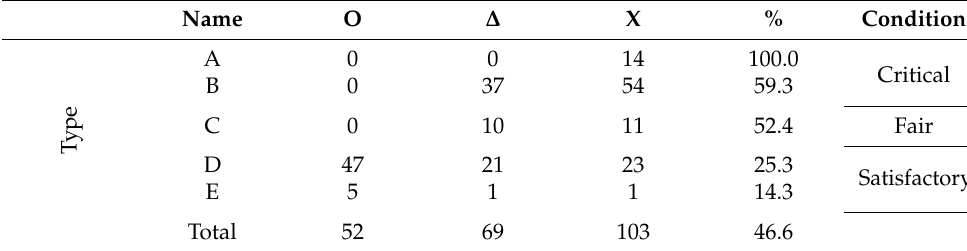
Table 13. Total issues results.